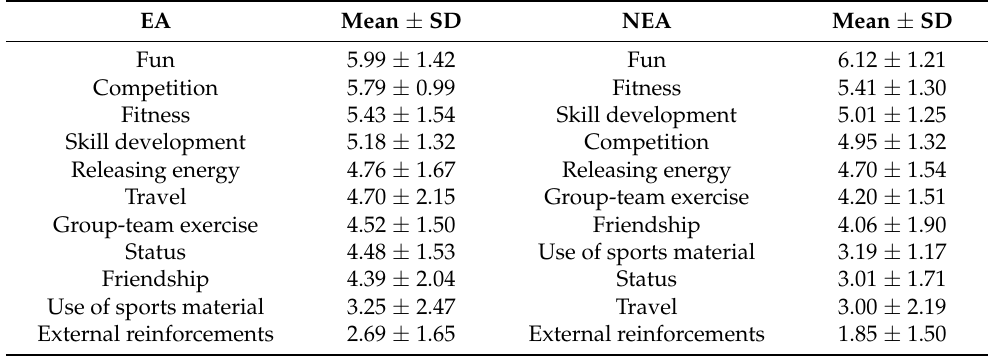
Table 3. The most important motivations for playing table tennis in elite and mid-level